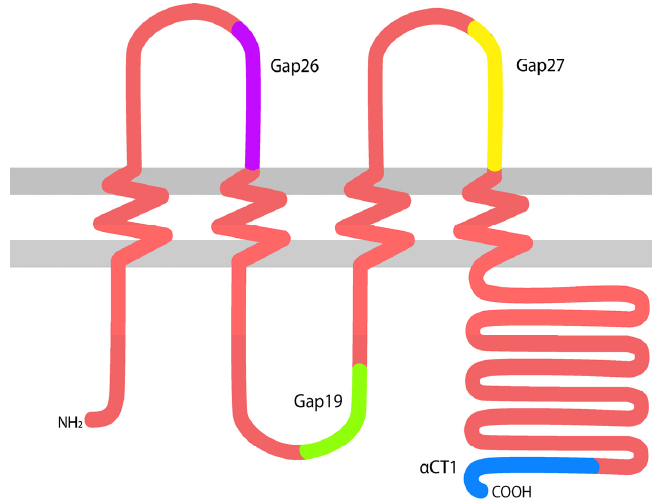
Figure 1. A diagram of connexin 43 (Cx43) spanning the cell membrane, with approximate locations highlighted from which several memetic peptides were derived. α CT1: alpha connexin carboxyl terminus 1.